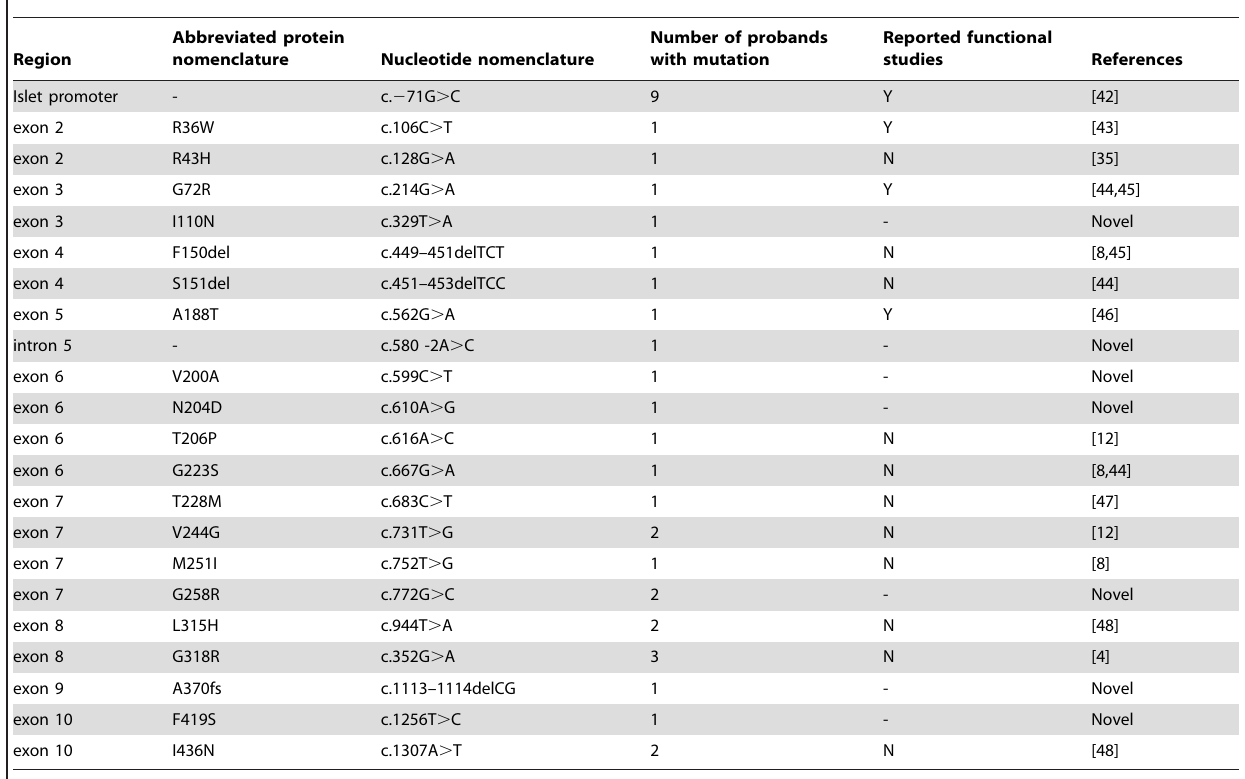
Table 1. GCK mutations identified in Slovakian probands with a phenotype of GCK-MODY.